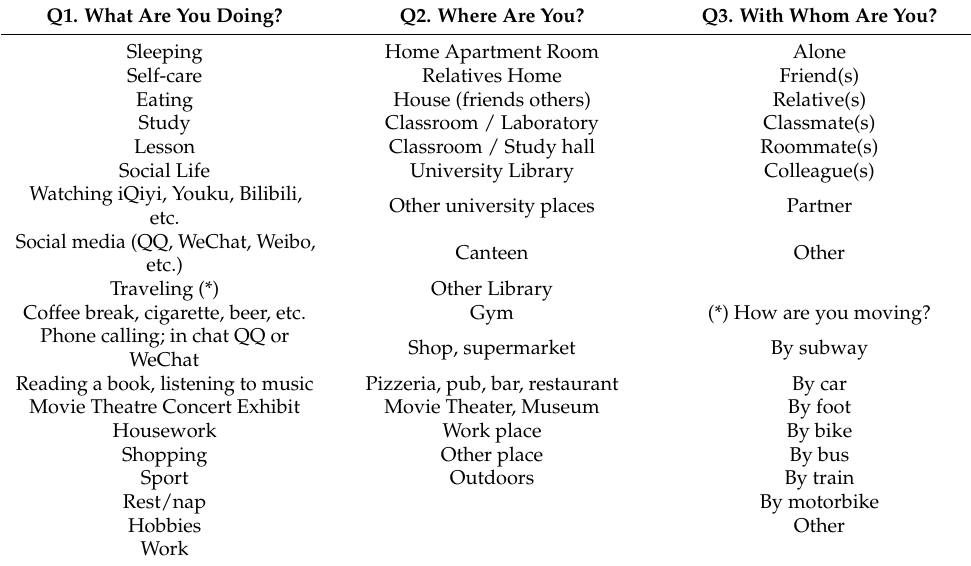
Table 3. The questionnaire for collecting activity